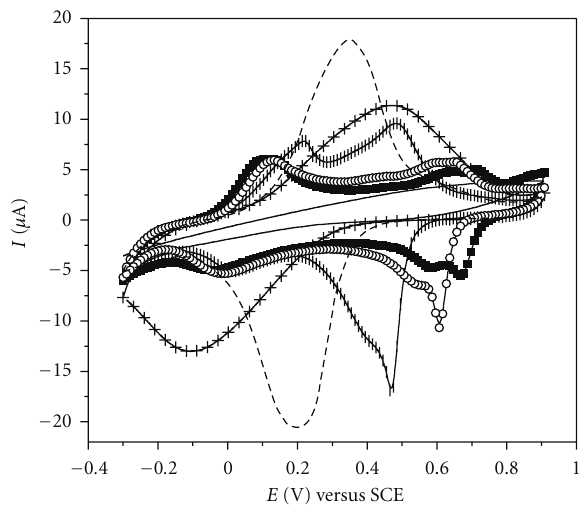
Figure 5: Cyclic voltammograms for LbL films from (PANI-PA/ CG) 6 in HCl electrolyte at di ff erent pHs (— (cid:2) — pH 1 initial; — —— pH 2; --- pH 3; —+— pH 4; — pH 5; — (cid:3) — pH 1 final). Scan rate: 50 mV s − 1